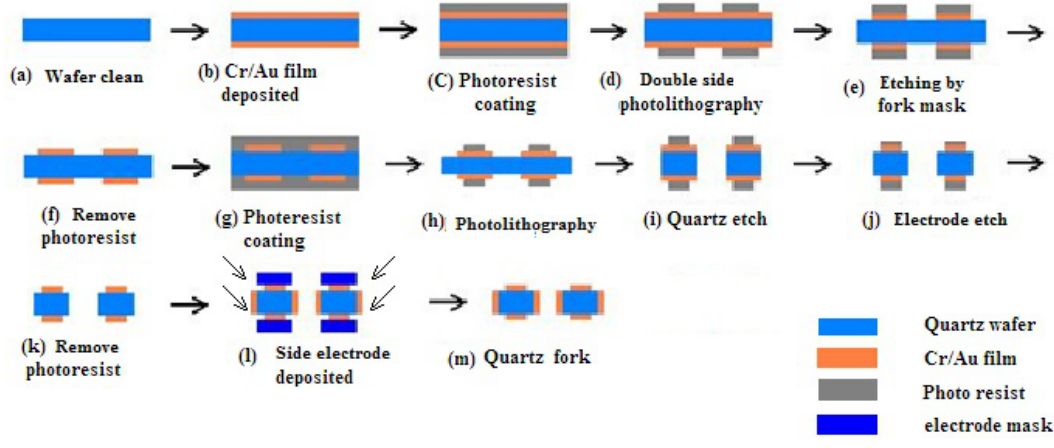
Figure 10. Packaged device.